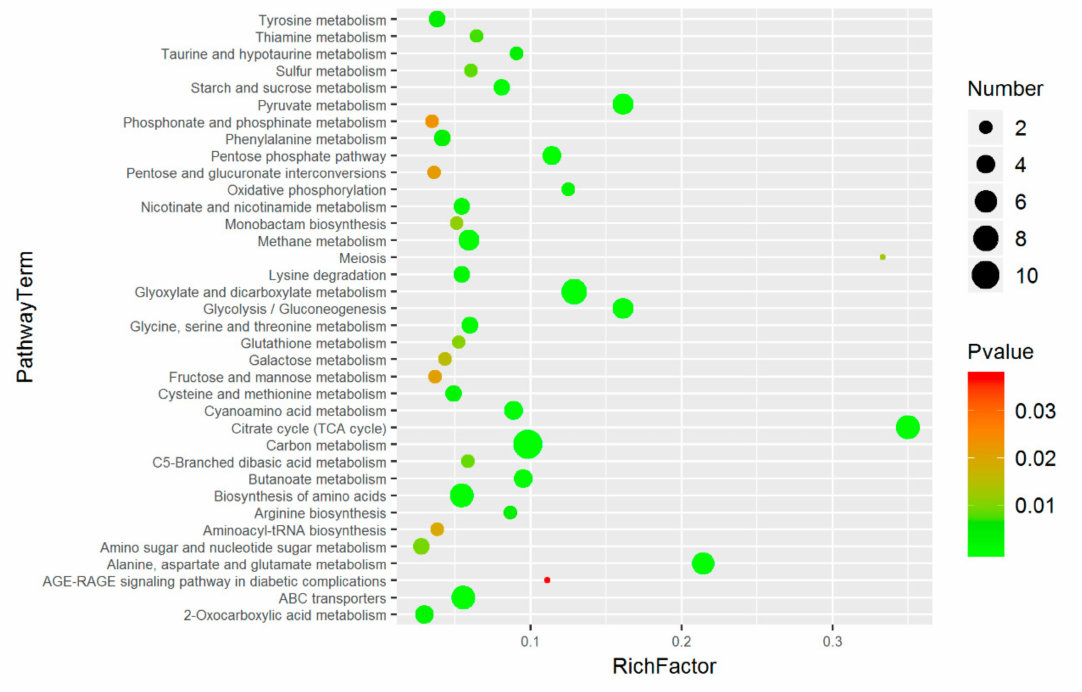
Figure 6. Pathway enrichment analysis of metabolites. A color-coded bar on the right represents the levels of significance. The green color indicates extremely significant levels at ( p < 0.01), while red color indicates significant levels at ( p < 0.05). The circles represent the number of metabolites involved or enriched in the pathway. Enrich factor refers to the ratio of the number of di ff erential metabolites expressed in the corresponding pathway to the total number of metabolites annotated by the pathway. The greater the value the greater is the degree of the